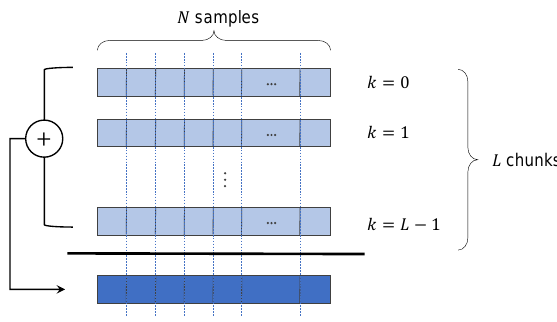
Figure 5. Accumulation of L chunks of N samples.